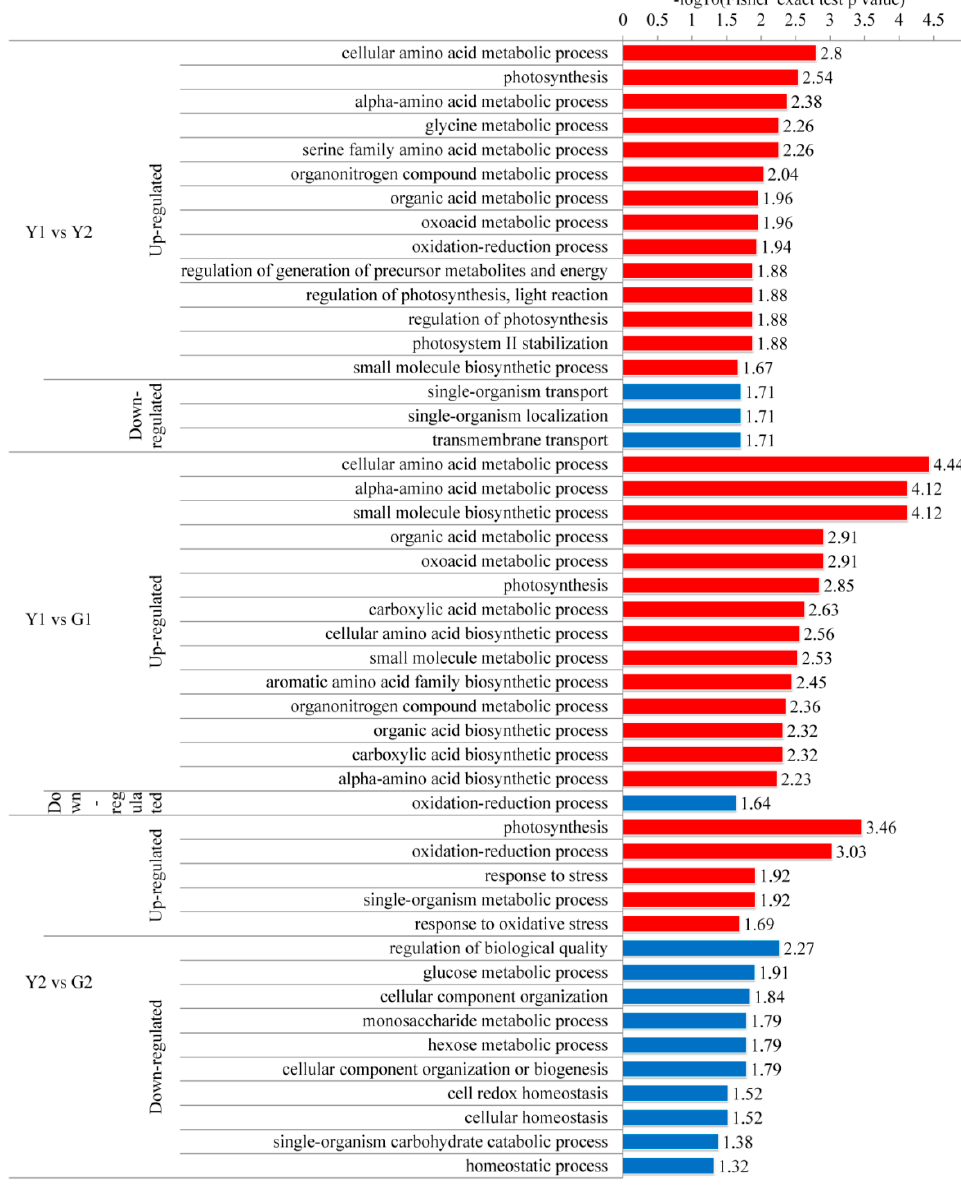
Figure 6. Gene ontology (GO) enrichment analysis of biological processes in the Y1 versus G1, Y1 versus Y2, and Y2 versus G2 comparisons. GO enrichment analysis of upregulated and downregulated proteins were